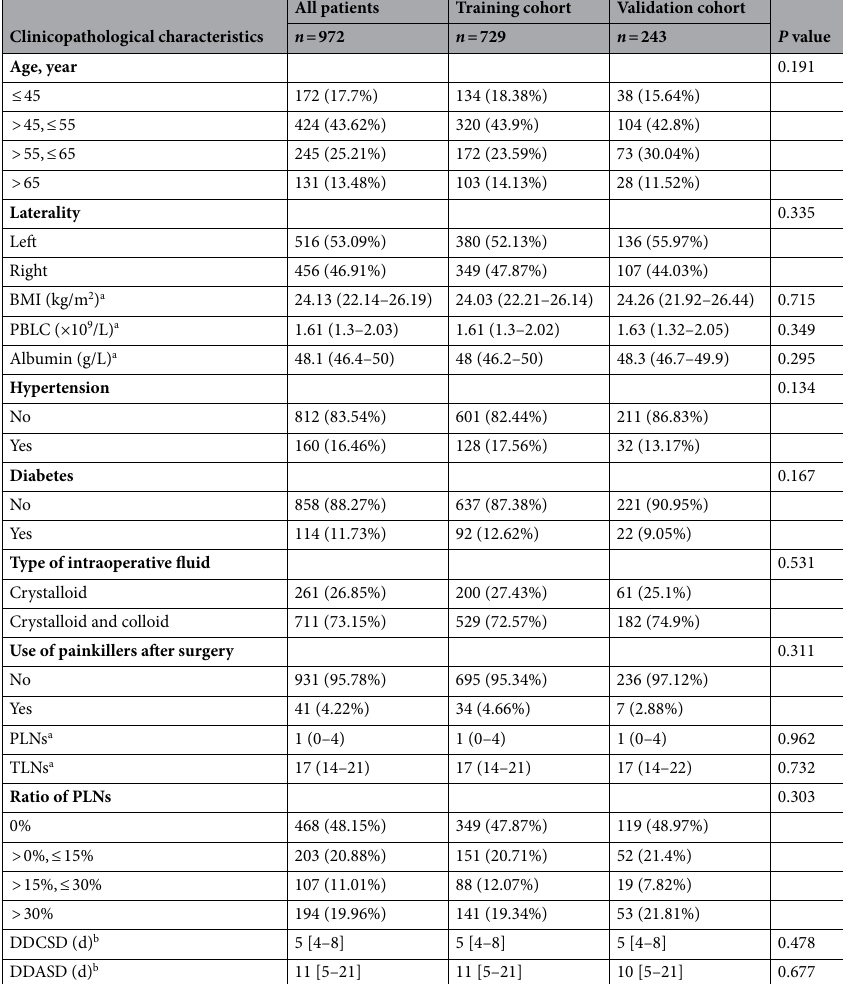
Table 1. Clinicopathological characteristics of patients with breast cancer in the present study. BMI, body mass index; DDASD, drainage duration of axillary suction drain; DDCSD, drainage duration of chest wall suction drain; PBLC, peripheral blood lymphocyte count; PLNs, number of positive axillary lymph nodes; ratio of PLNs, ratio of positive axillary lymph nodes; TLNs, number of total dissected axillary lymph nodes. a Shown as median (interquartile range).* b Shown as median